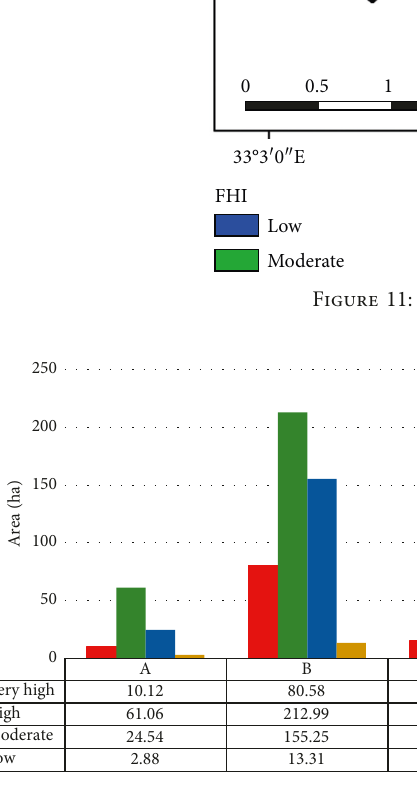
Figure 12: Categorization of each area.